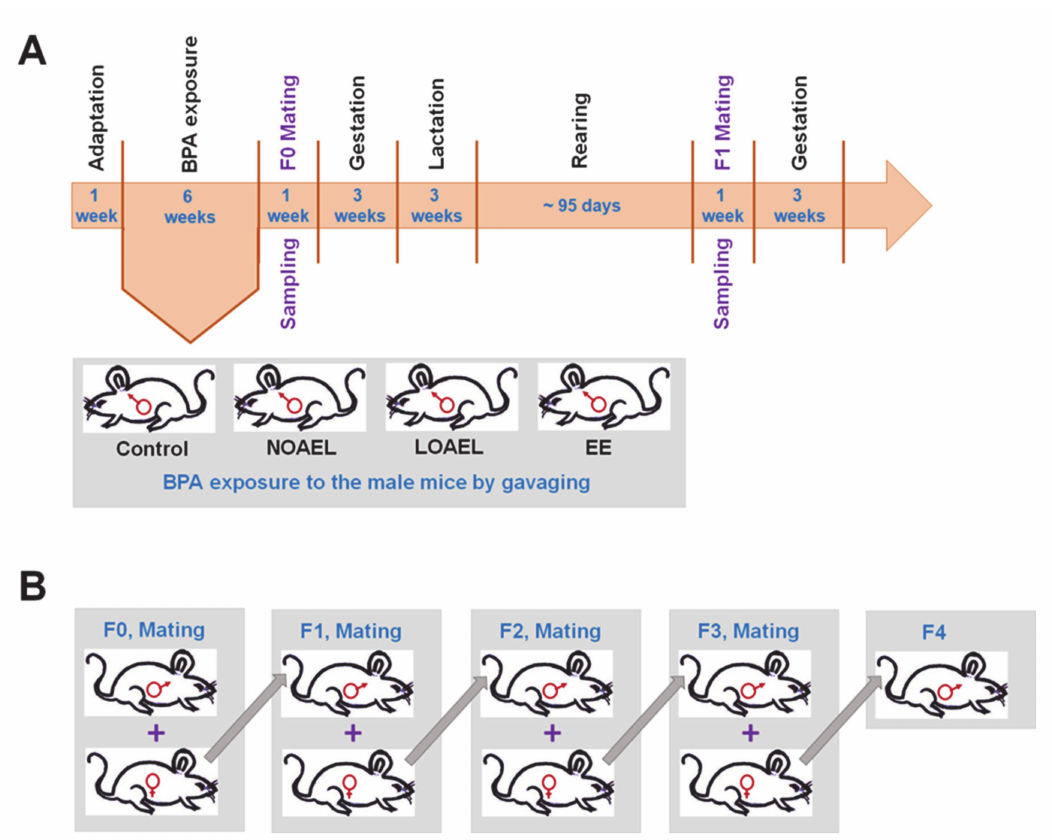
Figure 1. Experimental design. ( A ) After adaptation for one week, CD-1 male mice (F0) were gavaged with di ff erent bisphenol-A (BPA) doses [no-observed-adverse-e ff ect-level (NOAEL; 5 mg / kg body weight (bw) / day) and lowest-observed-adverse-e ff ect level (LOAEL; 50 mg / kg bw / day); see detailed dose description in the text], negative control (corn oil), and positive control (ethinylestradiol; EE). ( B ) Mating scheme to produce descendants (F0–F4 generation) where males were allowed to mate with outbred